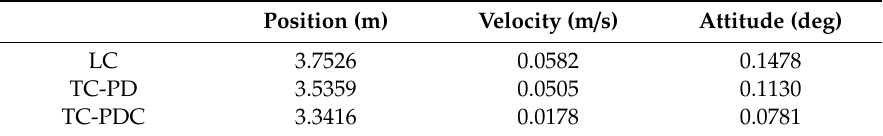
Table 4. RMSE comparison among LC, TC-PD, and TC-PDC with robust KF.